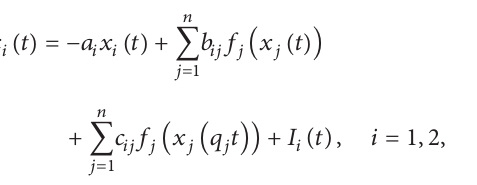
Figure 2: Synchronization errors of system (25) and system